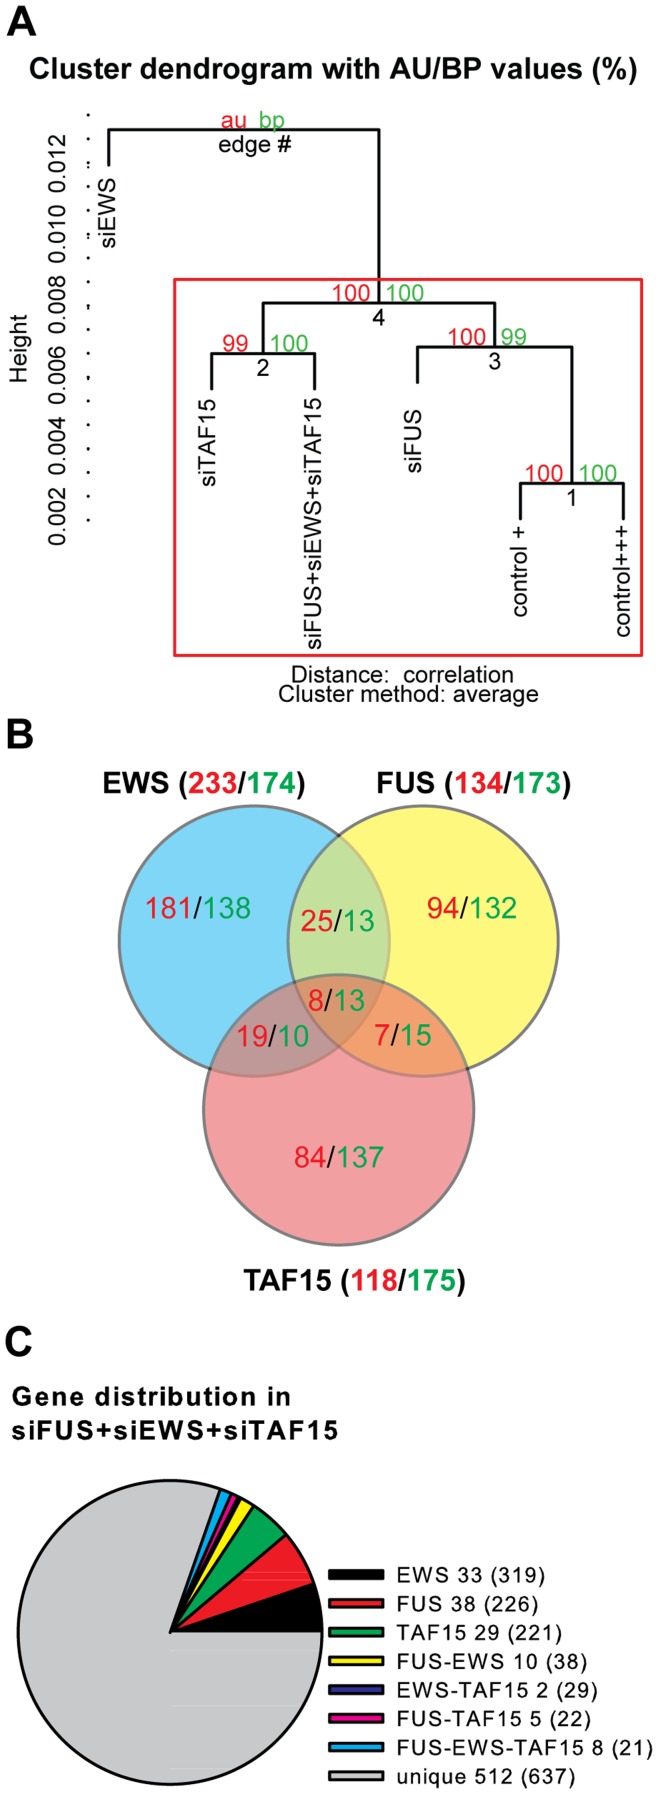
Analysis of the Illumina HumanGW 6 BeadChip whole genome expression array.(A) Hierarchical clustering by Pvclust by of the significantly expressed genes in HEK293-cells transfected with siRNAs for the FET mRNAs (siFUS, siEWS, siTAF15, siFUS+siEWS+siFUS) or an unspecific control siRNA (control + and control +++). The control + is control sample for the individual FET siRNA transfections, and the control +++ for the siFUS+siEWS+siTAF15 sample, to ensure the comparisons of equal siRNA concentrations. P-values (%) are shown on the edges of the clustering, Approximately Unbiased (AU) p-values in red, and Bootstrap Probability (BP) values in green. Clusters with an AU p-value greater than 95% are highlighted by a red rectangle. (B) The distribution of differentially expressed genes (DEGs) in the siFUS (yellow), siEWS (blue), and siTAF15 (light red) transfected cells. The up-regulated number of genes is shown in red and down-regulated in green. The number of common DEGs is shown in the overlapping parts of the circles. (C) DEGs in the siFUS, siEWS, and siTAF15 transfected cells. The common DEGs were compared to the DEGs in the siFUS+siEWS+siTAF15 transfected cells. In total 637 DEGs are identified in the siFUS+siEWS+siTAF15 cells, of those are 512 unique genes (grey). 33 of the 319 common DEGs in siEWS transfected cells were found (black), 38 of 226 in FUS (red), 29 of 221 in TAF15 (green), 10 of 38 in FUS and EWS (yellow), 2 of 29 in EWS and TAF15 (dark blue), 5 of 22 in FUS and TAF15 (pink), and 8 of 21 in FUS and EWS and TAF15 were found (blue).